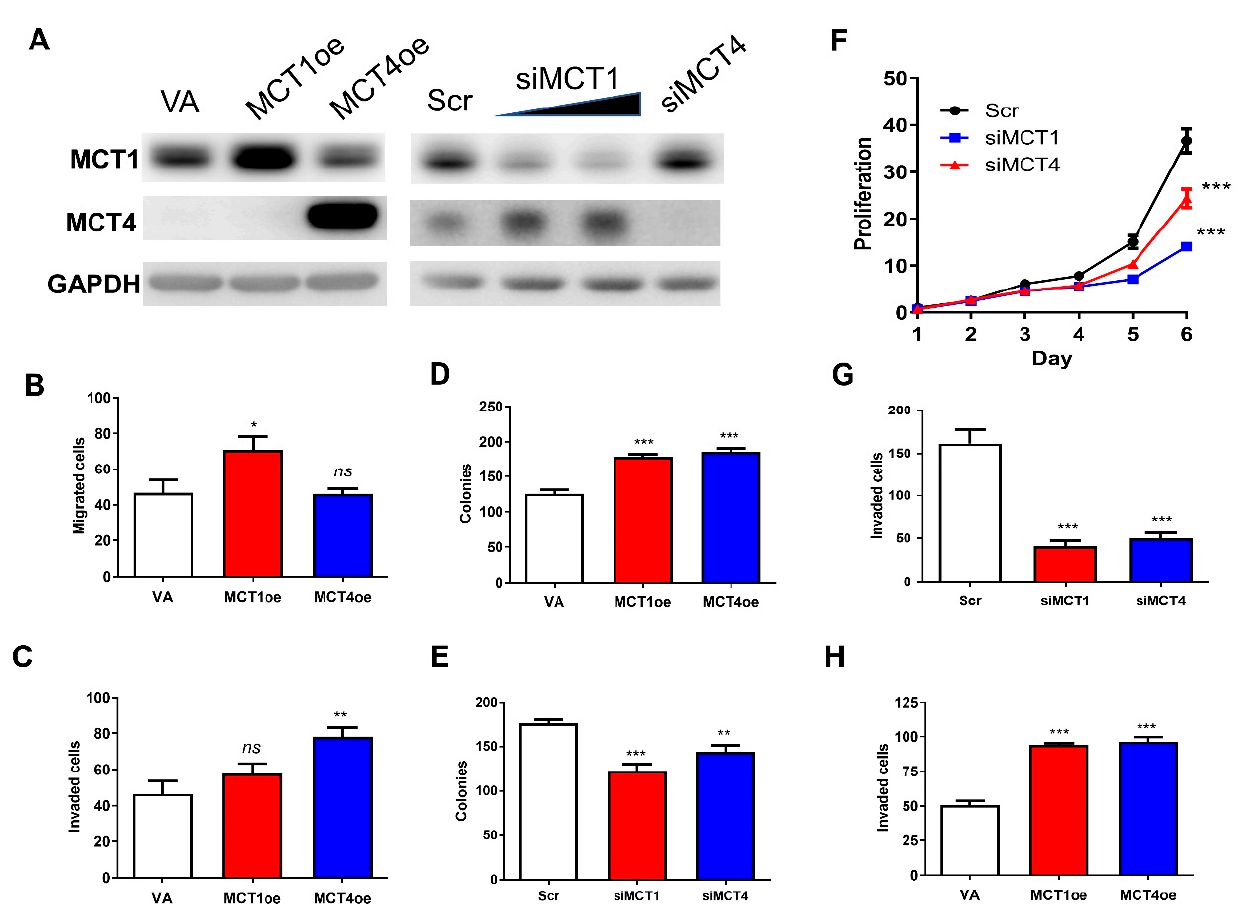
Figure 5. Association between MCT1/MCT4 expression and OSCC oncogenicity. ( A – E ) SAS cells. ( F – H ) OECM1 cells. ( A ) Western blot analysis to confirm the exogenous expression or knockdown of MCT1 or MCT4 in SAS cells. The signal intensity of MCT4 image in left panel was attenuated to acquire better illustration. Regulation between MCT1 and MCT4 seemed to exist. ( B ) Migration assay. ( C , G , H ) Invasion assay. ( D , E ) Anchorage-independent colony formation. ( F ) Proliferation. ( B – D ) Exogenous MCT1 or MCT4 expression generally increased the migration, invasion and colony formation of SAS cells. ( E ) Knockdown of MCT1 or MCT4 significantly decreased colony formation in SAS cells. ( F ) Knockdown of MCT1 or MCT4 decreased the proliferation of OECM1 cells. ( G , H ) Knockdown of MCT1 or MCT4 decreased invasion, while exogenous expression increased the invasion of OECM1 cells. Scr, scramble oligonucleotide; VA, vector alone. ns , not significant; *, p < 0.05; **, p < 0.01; ***, p <